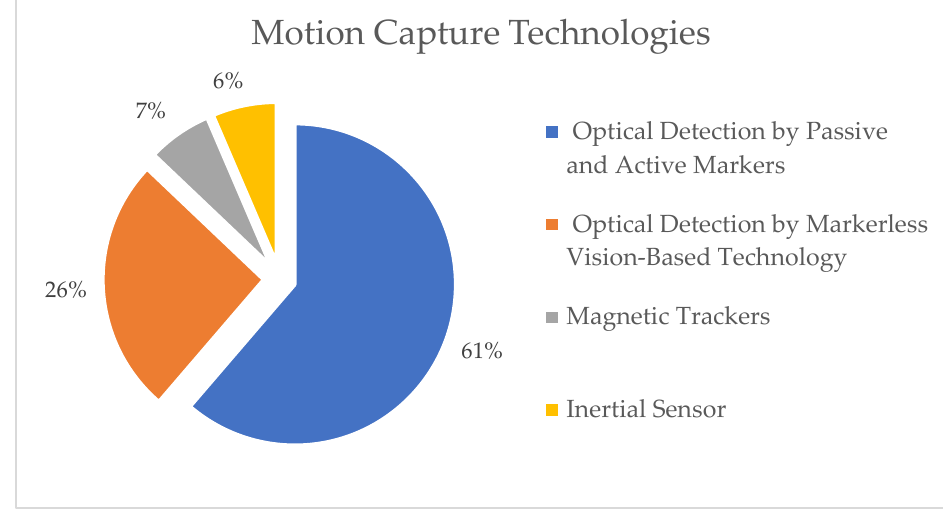
Figure 6. Classification of the studies based on the motion tracking technologies.